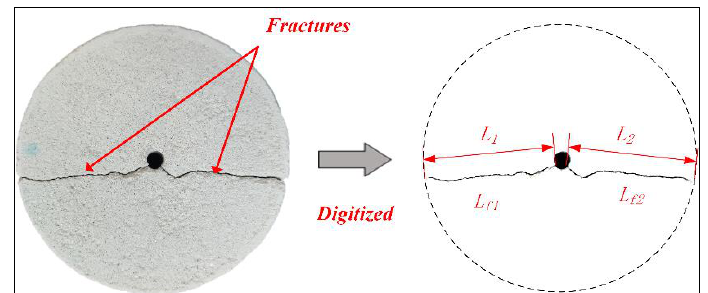
Figure 8. A schematic of the fracture tortuosity calculation.